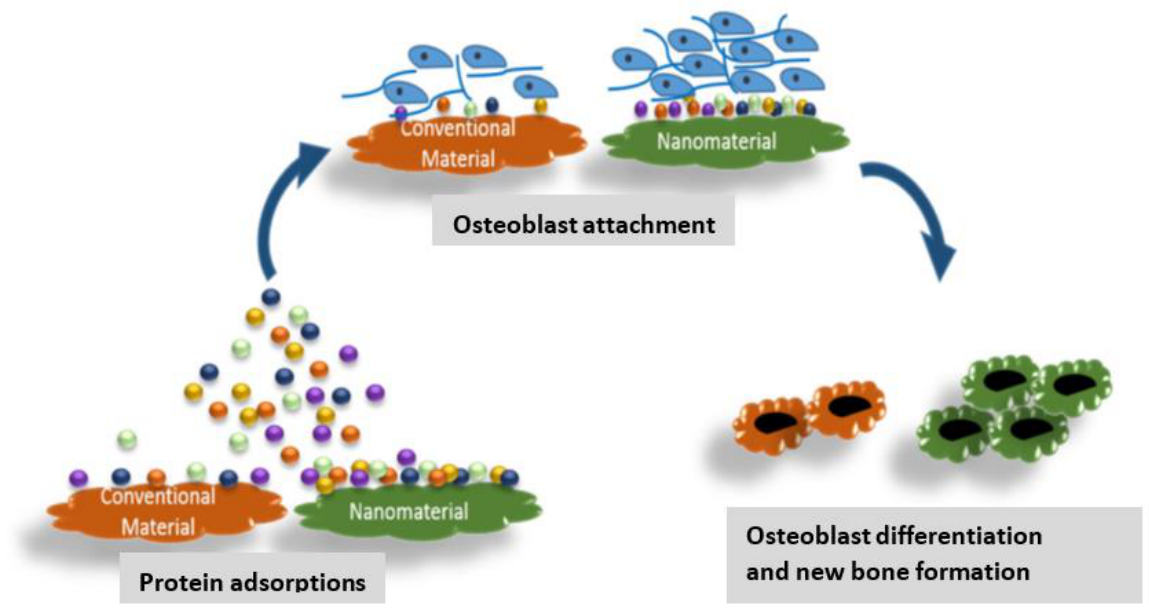
Figure 23. Comparison of bone regeneration using nanomaterials and traditional materials. Nano- materials show improved protein adsorption, osteoblast anchoring, and differentiation compared to traditional materials. Reproduced from ref. [143], copyright 2020, with permission from Elsevier.